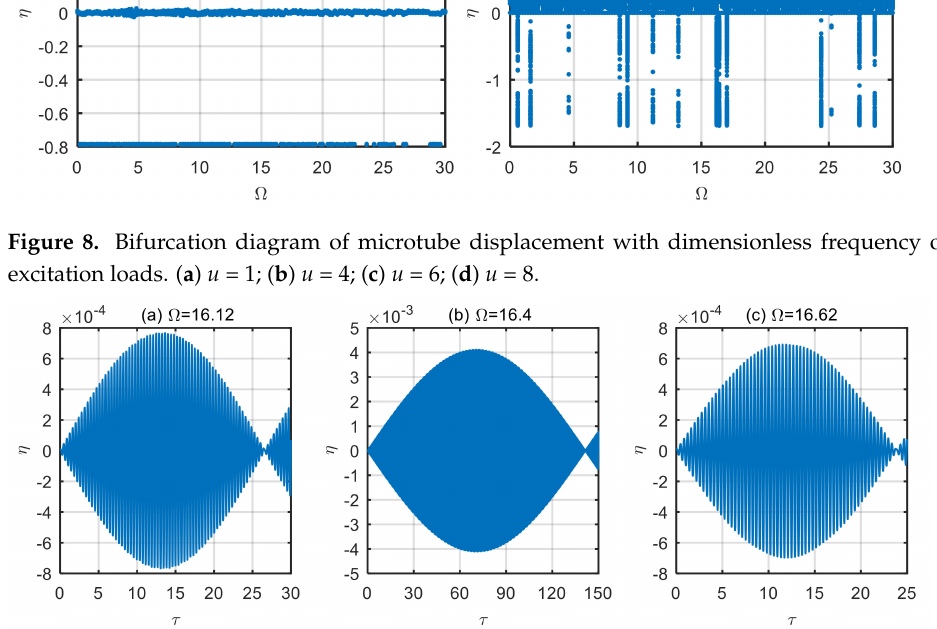
Figure 9. Displacement time history diagram of microtubes with different dimensionless frequencies of excitation loads ( u = 1). ( a ) Ω = 16.12; ( b ) Ω = 16.4; ( c ) Ω =